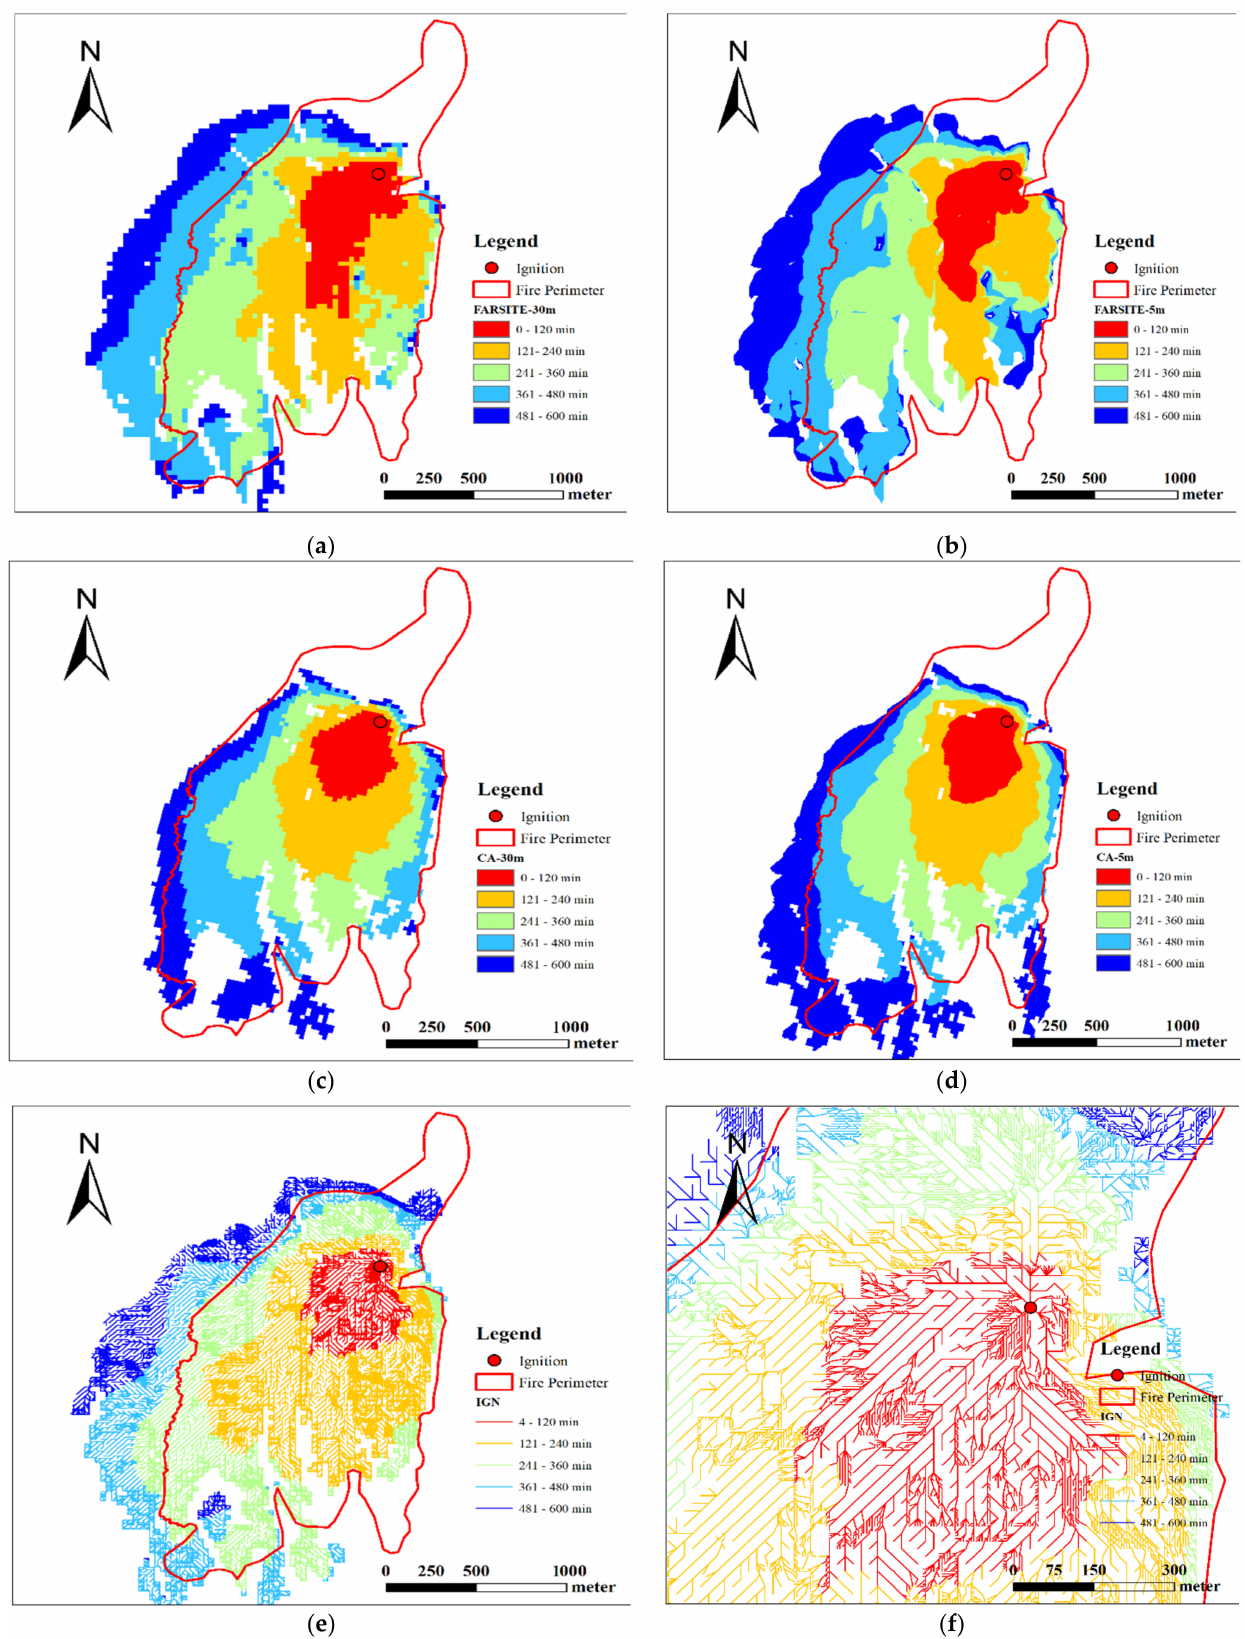
Figure 7. Experimental simulation results. ( a ) FARSITE model [30 m]; ( b ) FARSITE model [5 m]; ( c ) CA model [30 m]; ( d ) CA model [5 m]; ( e ) IGN model; ( f ) local IGN